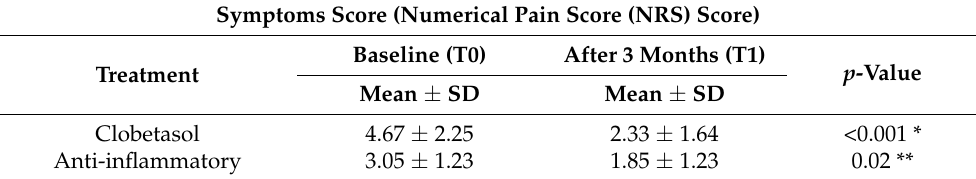
Table 3. Variation of the OLP symptoms score after the administration of the two protocols adopted. SD, standard deviation.